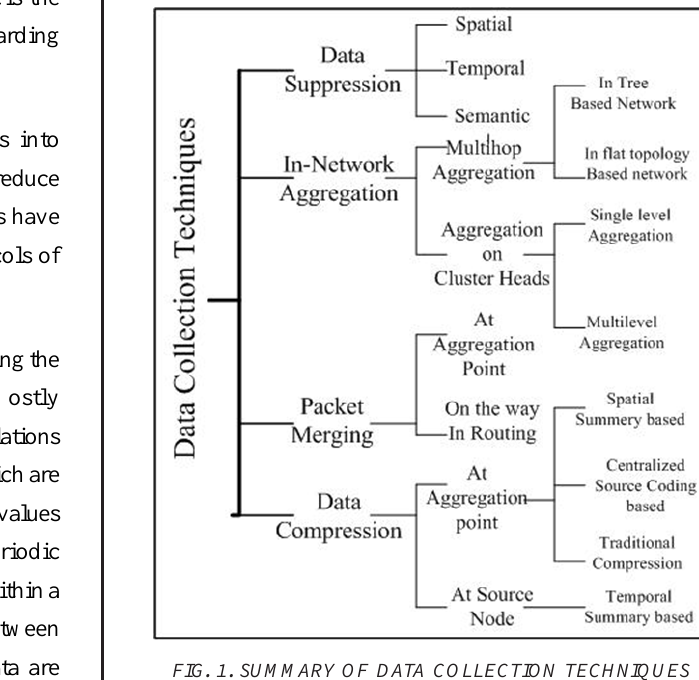
FIG. 1. SUMMARY OF DATA COLLECTION